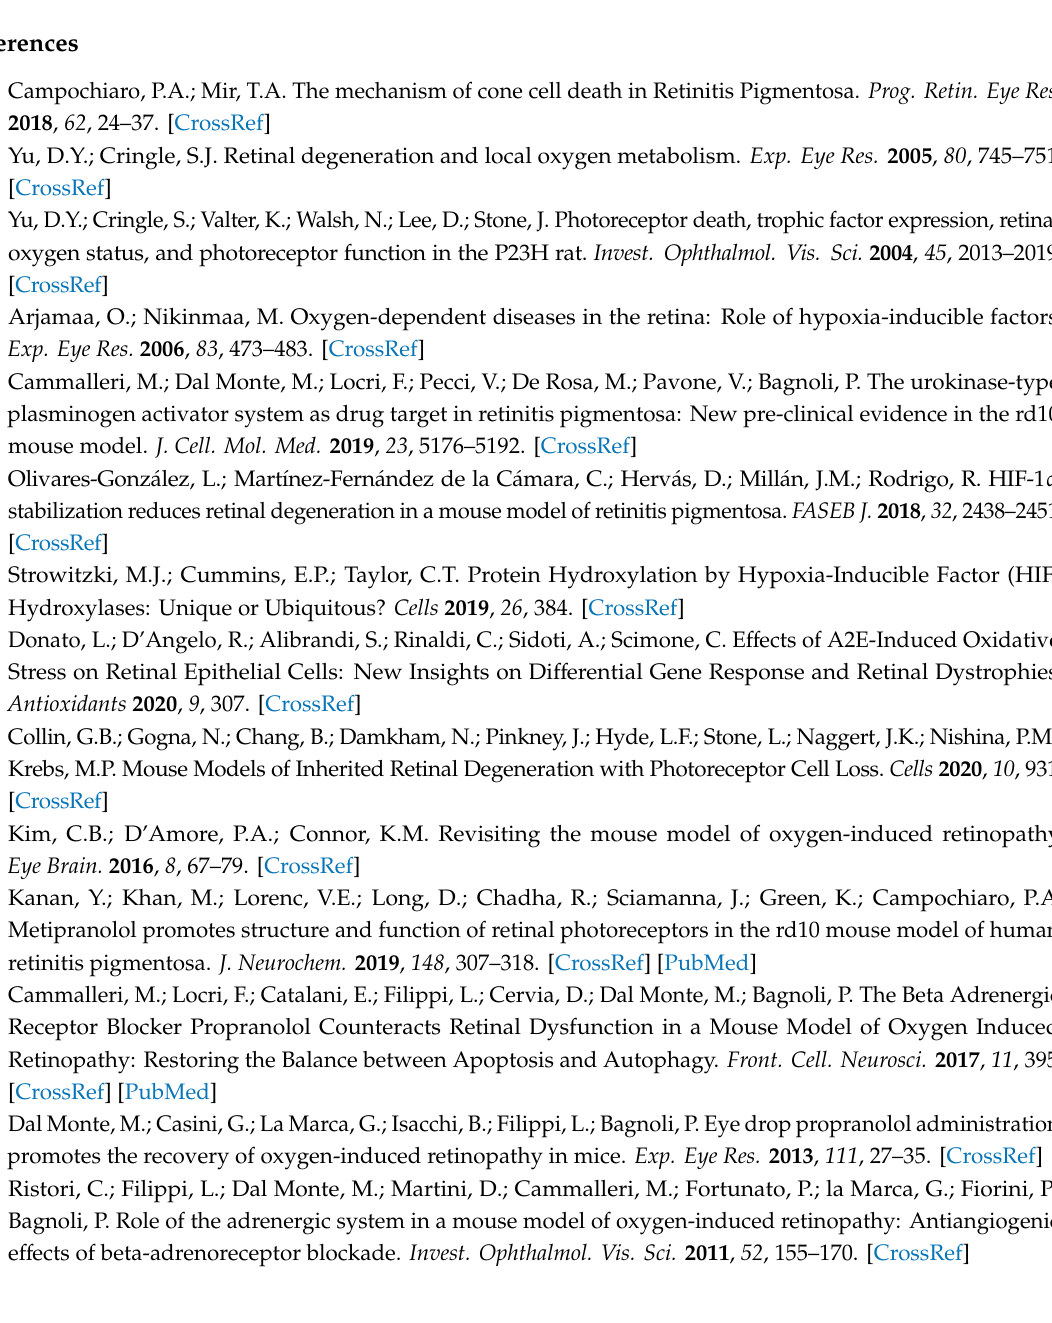
Table S1. Sequences of primer pairs used for qPCR experiments; Table S2: List of antibodies used in Western blot